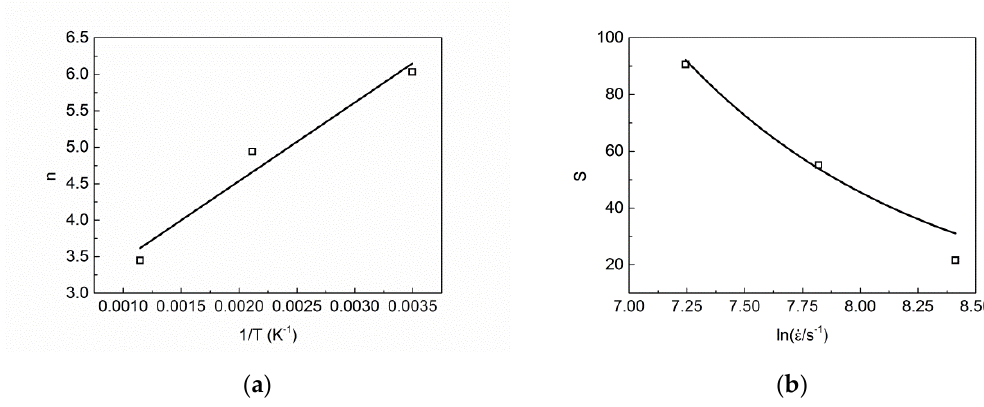
Figure 20. The function relation of ln (sinℎ 𝛼𝜎 𝑝 ) with ( a ) ln𝜀̇ and ( b ) 1/ T , respectively.